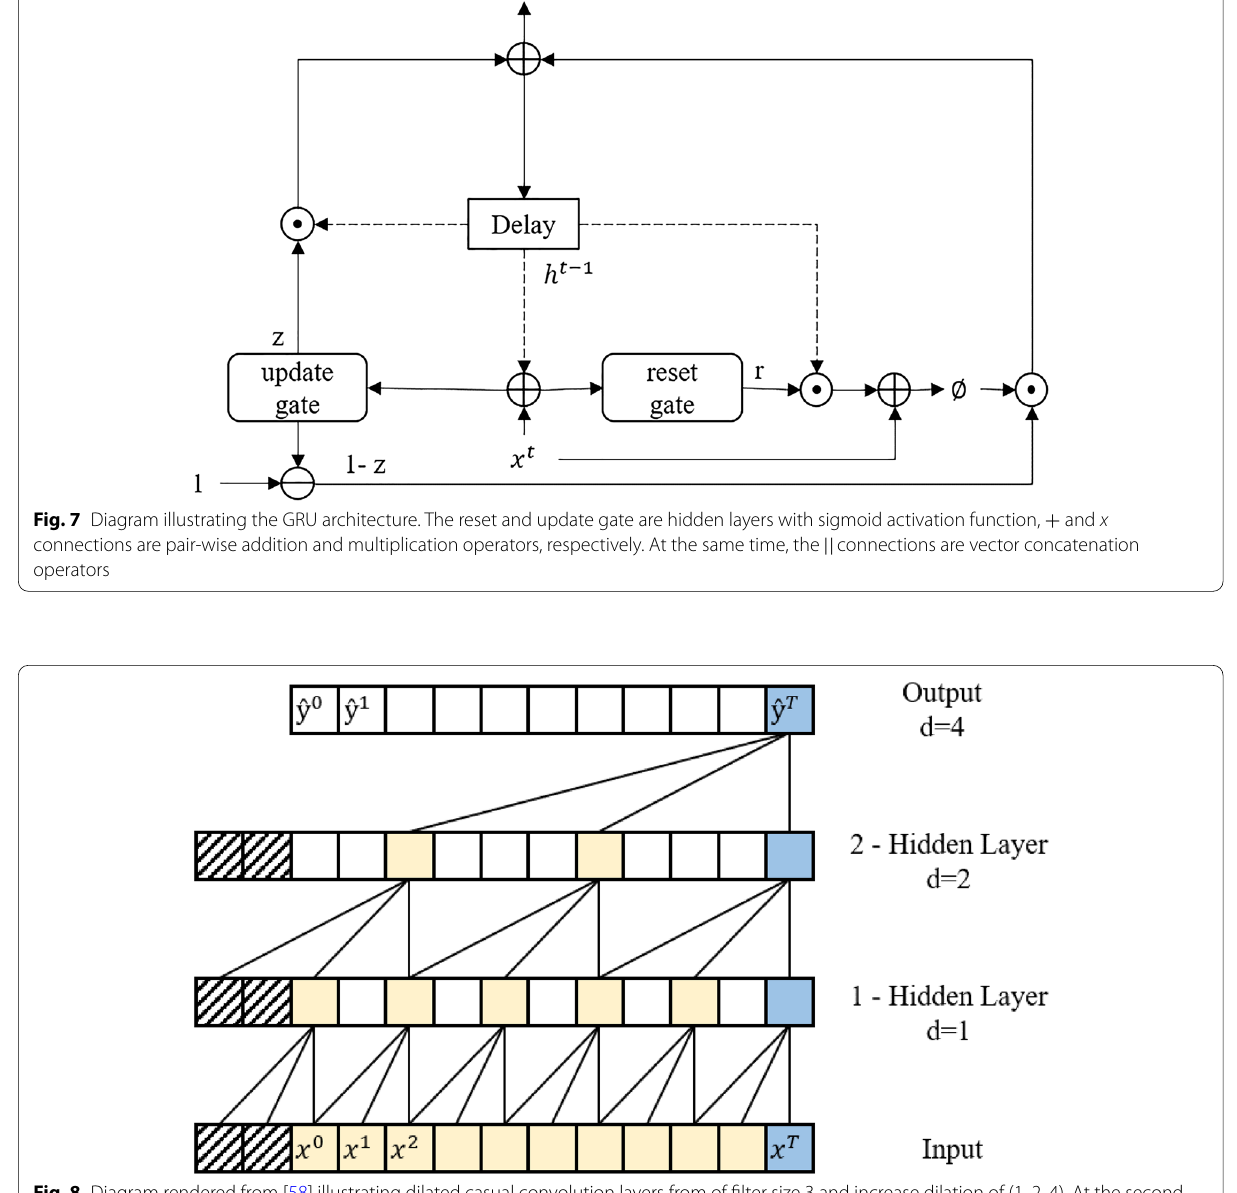
Fig. 8 Diagram rendered from [58] illustrating dilated casual convolution layers from of filter size 3 and increase dilation of (1, 2, 4). At the second hidden layer, a neurons field of view is 6 (i.e., its scope allows it two see up to 6 input sequence within the